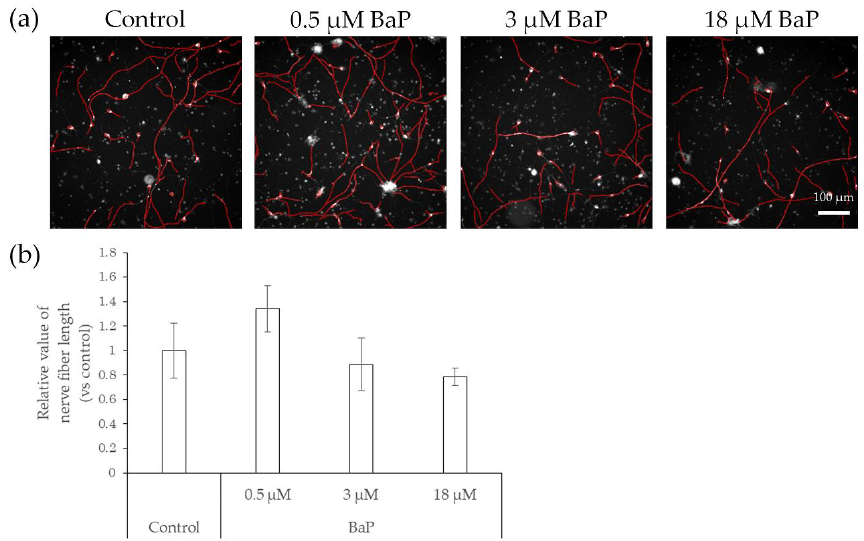
Figure 5. Effects of direct action of BaP on nerve fiber elongation of hiPSC-SNs. After culturing for 3 days, hiPSC-SNs were incubated with a medium containing BaP for 24 h and stained with NeuO. ( a ) Representative images with nerve fibers, outlined in red, were obtained using IN Cell Analyzer 2200. The red lines indicate NeuO-stained nerve fibers. ( b ) Total nerve fiber length versus control after incubation with various doses of BaP. Each value represents the mean ± standard deviation of three to four wells. BaP: benzo[a]pyrene.